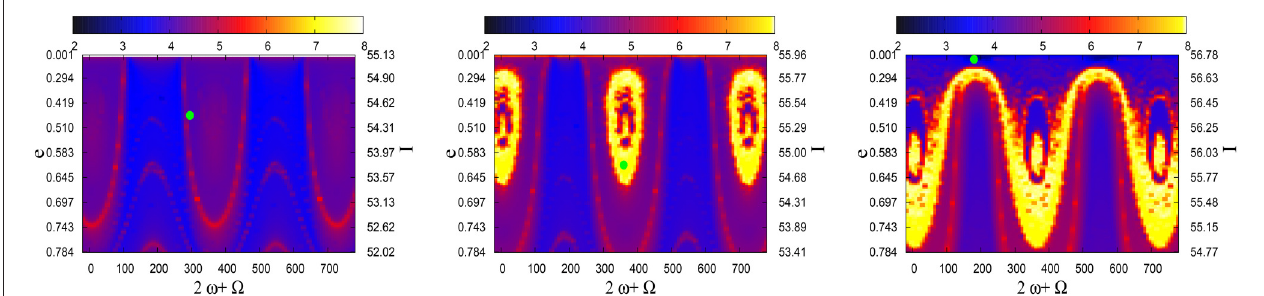
FIGURE 4 | Integration of the orbits having the initial conditions (cid:127) = 180 ◦ and: σ = 295 ◦ , T = 0.06 , S = 0.37 (or e = 0.467 , I = 54.47 ◦ ) (top plots); σ = 360 ◦ , T = 0.05 , S = 0.33 (or e = 0.615 , I = 54.85 ◦ ) (middle plots); σ = 180 ◦ , T = 0.04 , S = 0.415 (or e = 0.13 , I = 56.76 ◦ ) (bottom plots).